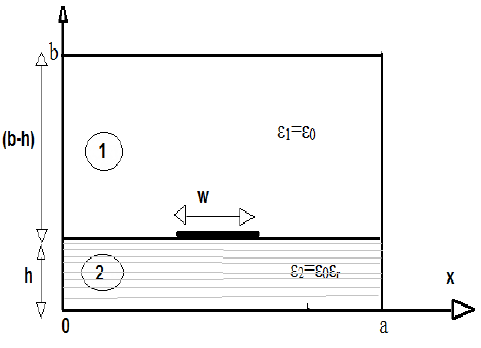
Figure1: Shielded microstrip line geometry [10].